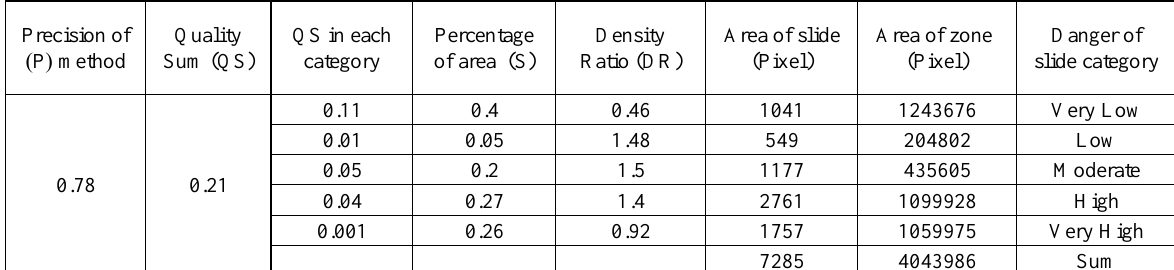
Table 3. Validation and accuracy of landslide hazard zonation using gamma operator of